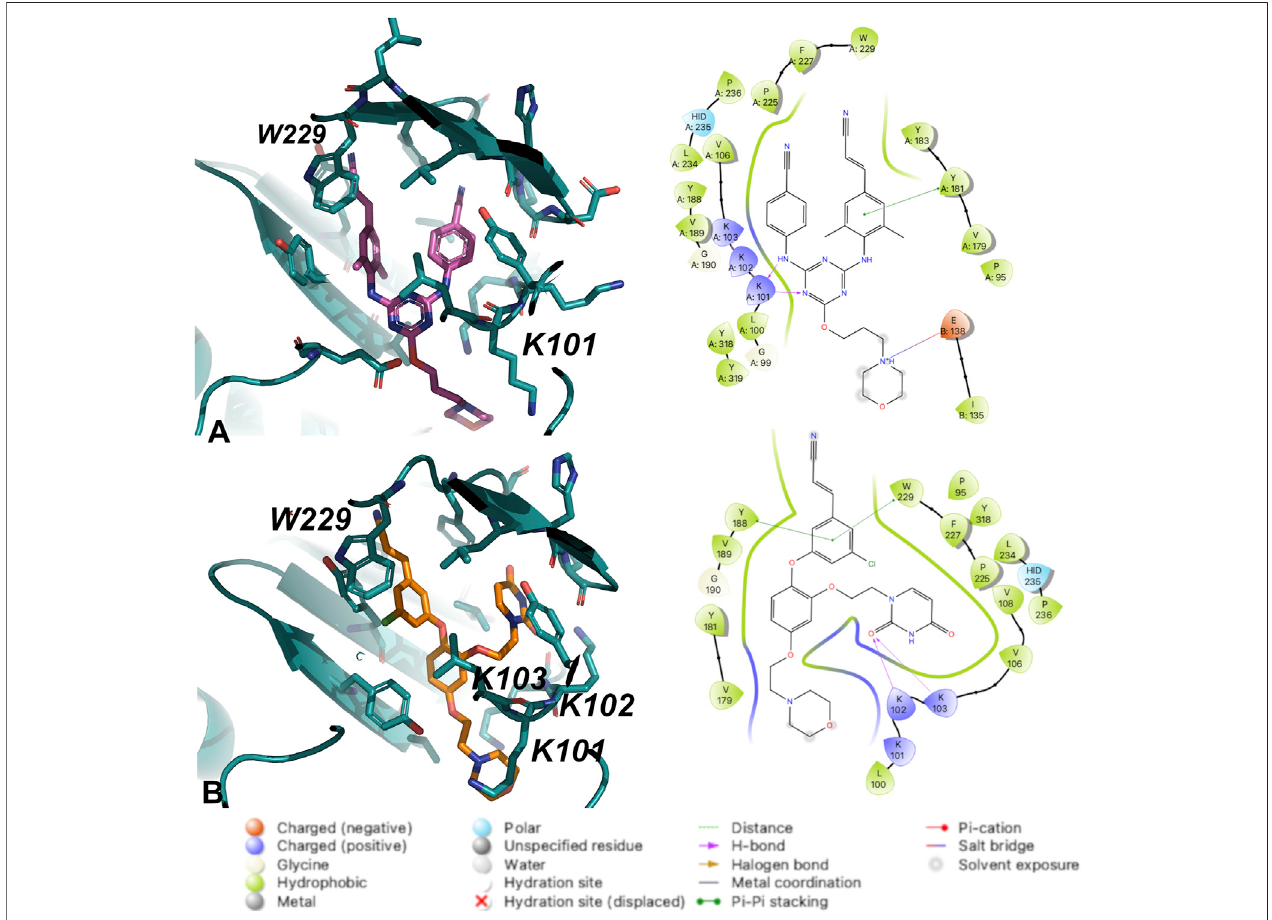
FIGURE3| Interactionsbetween (A) Compound 2 and (B) Compound 1 withresiduesintheNNIBPofRT(WT).3Ddepictionofinteractions(left)and2Dschematic diagram of interactions (right). Hydrogen bonds are represented by purple arrows; π - π interactions are represented bygreen lines between aromatic rings and residues; van der Waals contacts are made between all listed residues within a radius of 4 Å. The key provided speci fi es residue type, water molecules, and interactions.